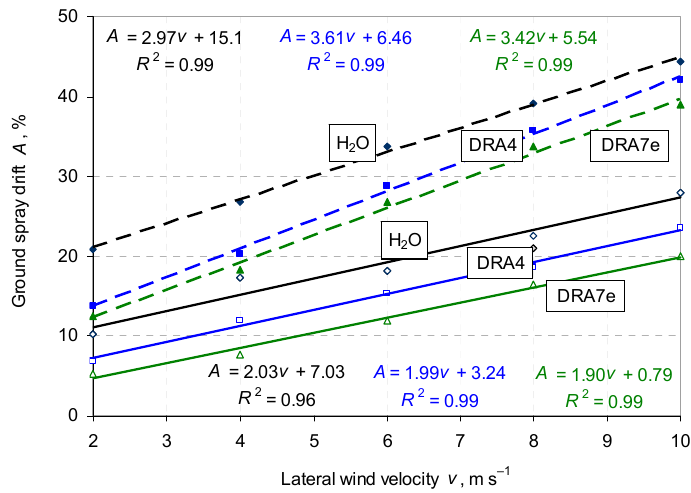
Figure 8. Droplet ground spray drift as a function of lateral air velocity and solution type for air-injector flat spray ( ) and standard flat spray ( ) nozzles in a wind tunnel.